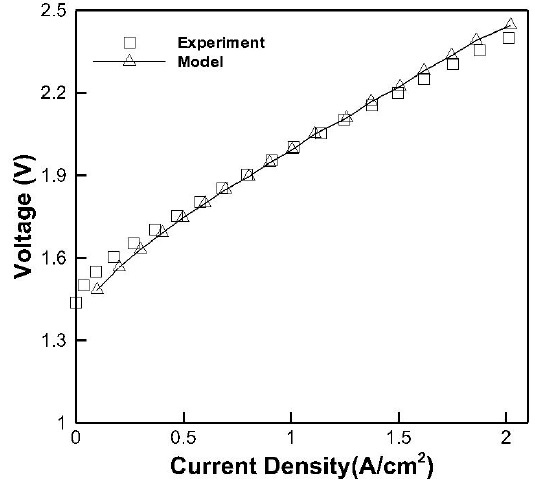
Figure 3. Model validation performed at a flow rate of 20 cm 3 /min.